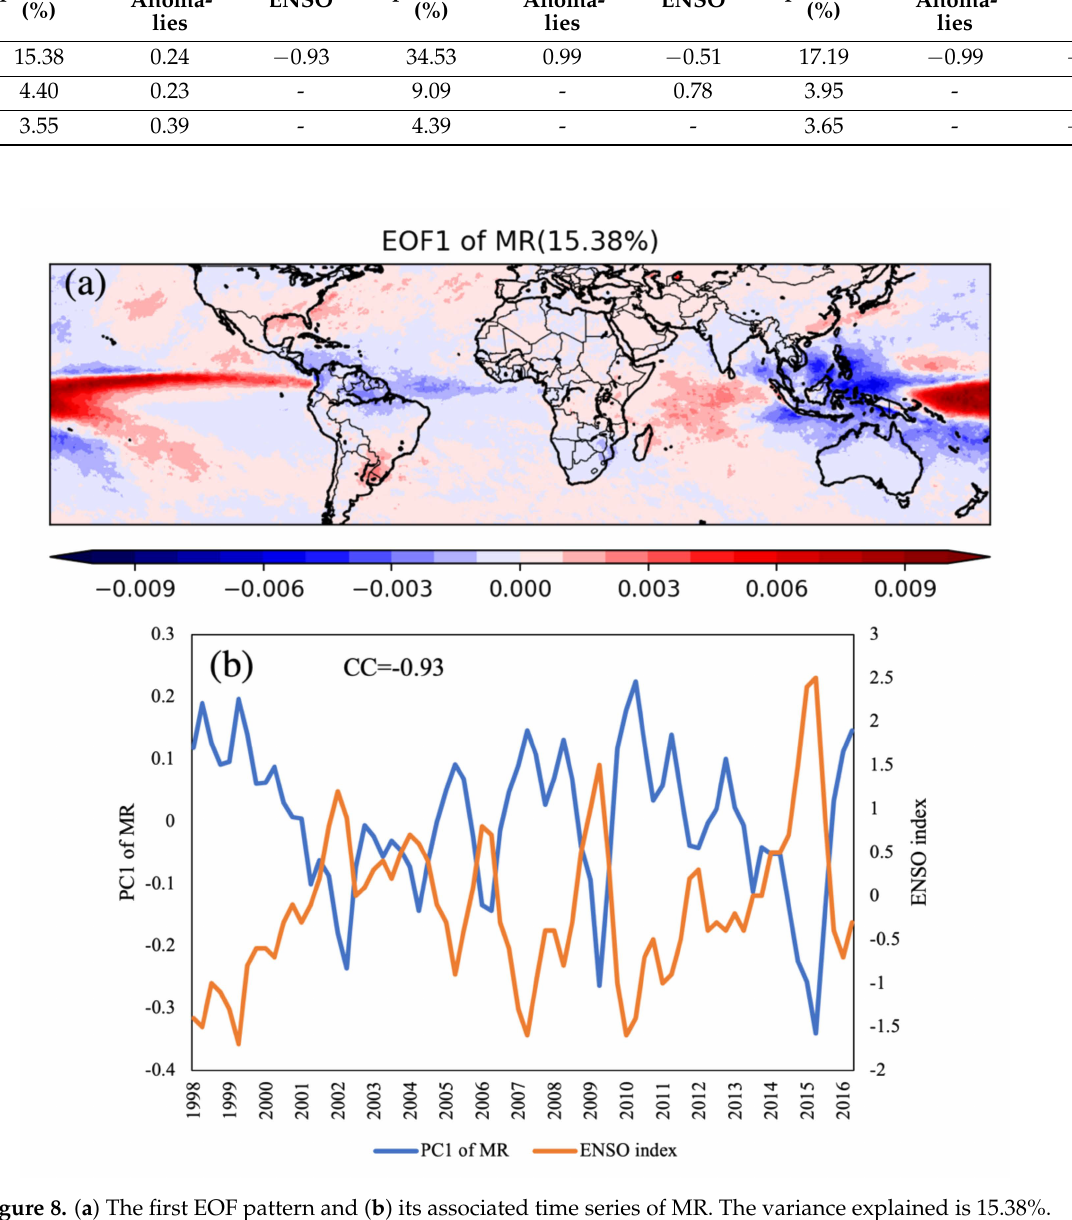
Figure 8. ( a ) The first EOF pattern and ( b ) its associated time series of MR. The variance explained is